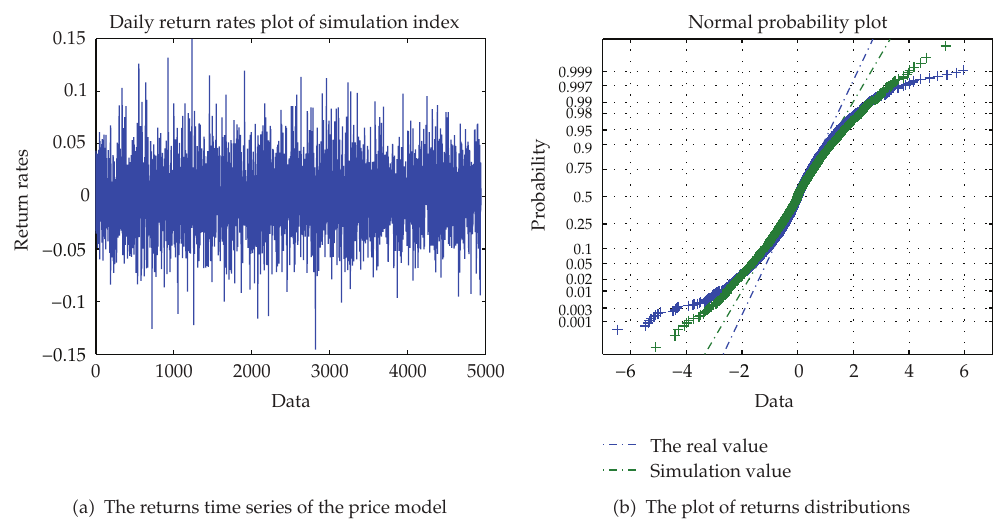
Figure 2: (cid:2) a (cid:5) The returns time series of simulation data for the price model with the intensity p (cid:6) 0 . 49. (cid:2) b (cid:5) The comparison of returns distributions for 20-year period Hang Seng index and the simulative data with p (cid:6) 0 . 49.